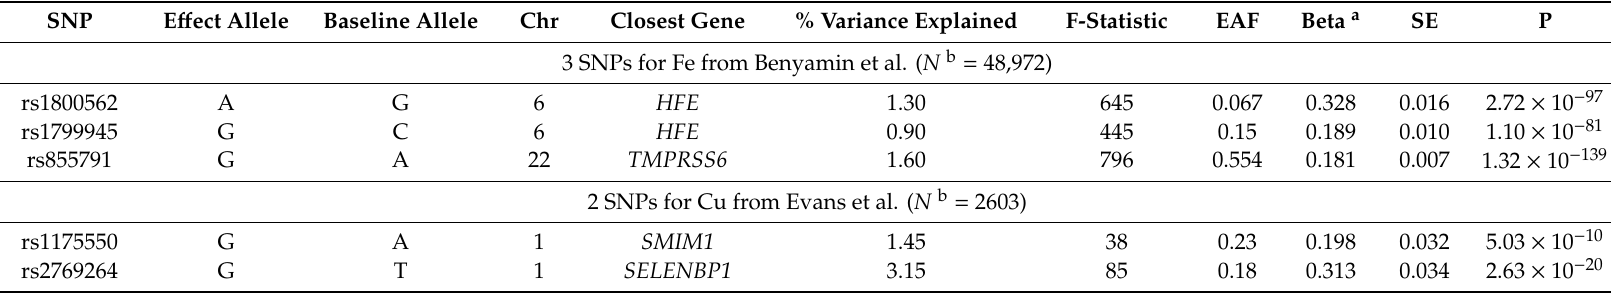
Table 1. Single nucleotide polymorphisms (SNPs) used as genetic instruments for blood minerals in the phenome-wide association study (PheWAS) and Mendelian randomization (MR) analyses. E ff ect